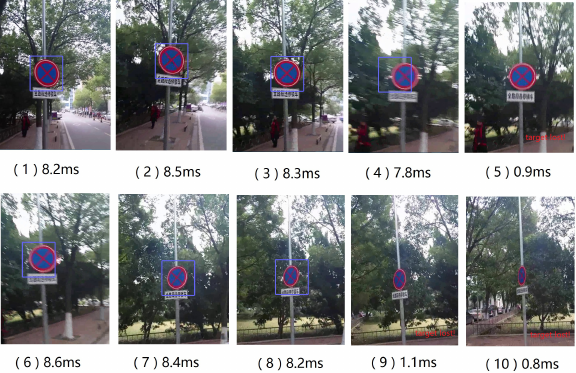
Figure 19: Error Ellipse detection result by our algorithm in frame sequence